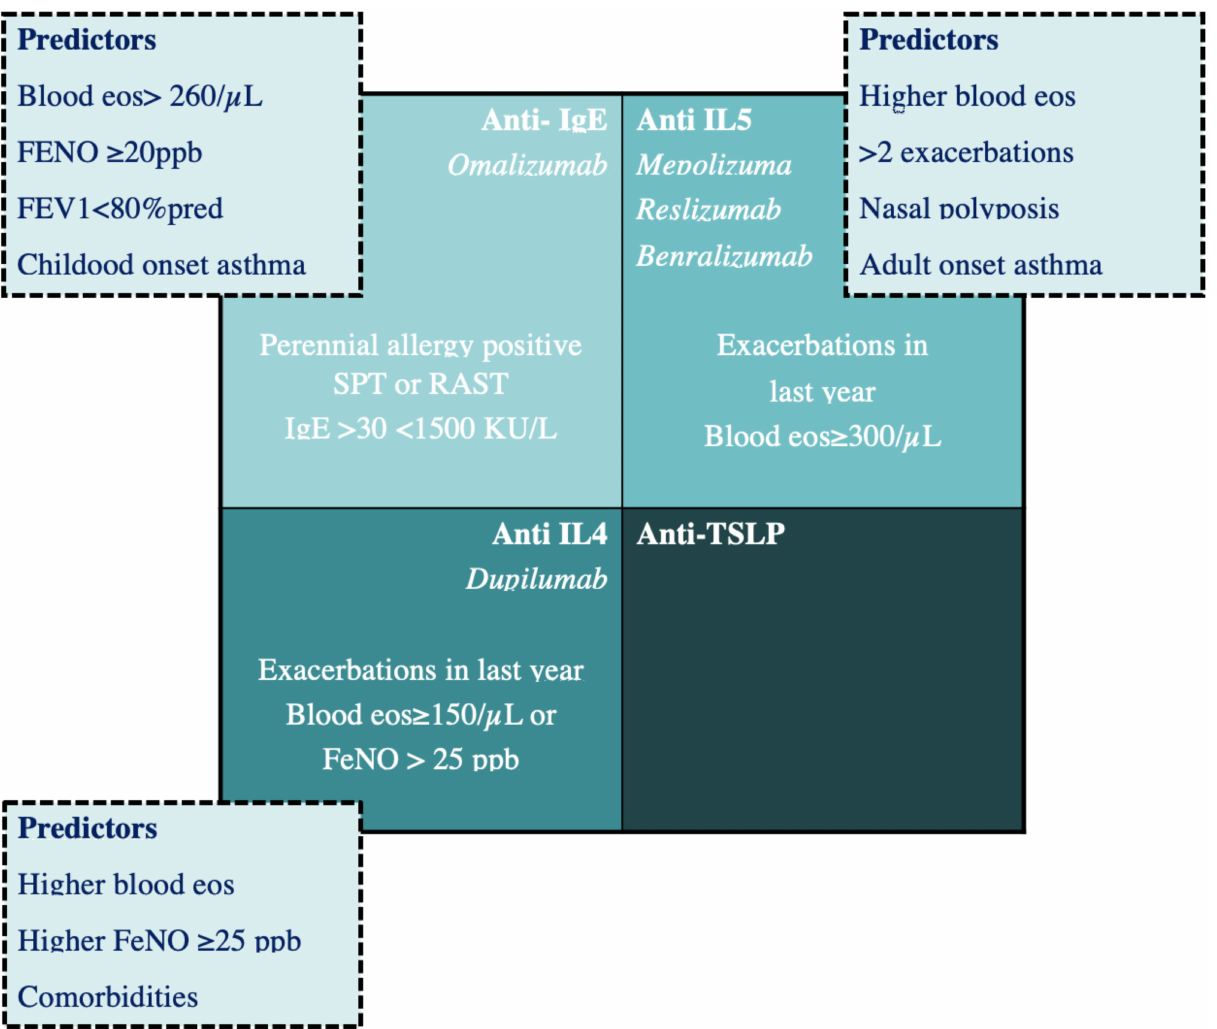
Figure 2. Biologics approved for the treatment of severe asthma: mechanisms, patient selection criteria, and predictors of good